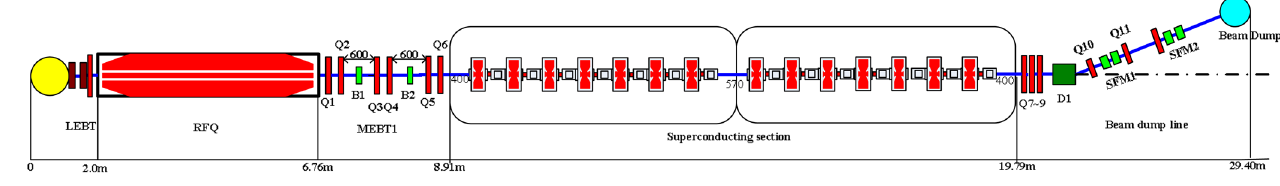
FIG. 2. The schematic layout of the 10 MeV test stand in IHEP.